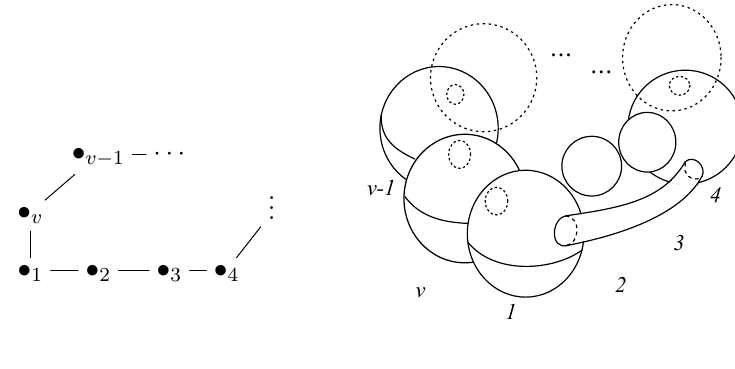
Figure 7 . Schematic topology of B L